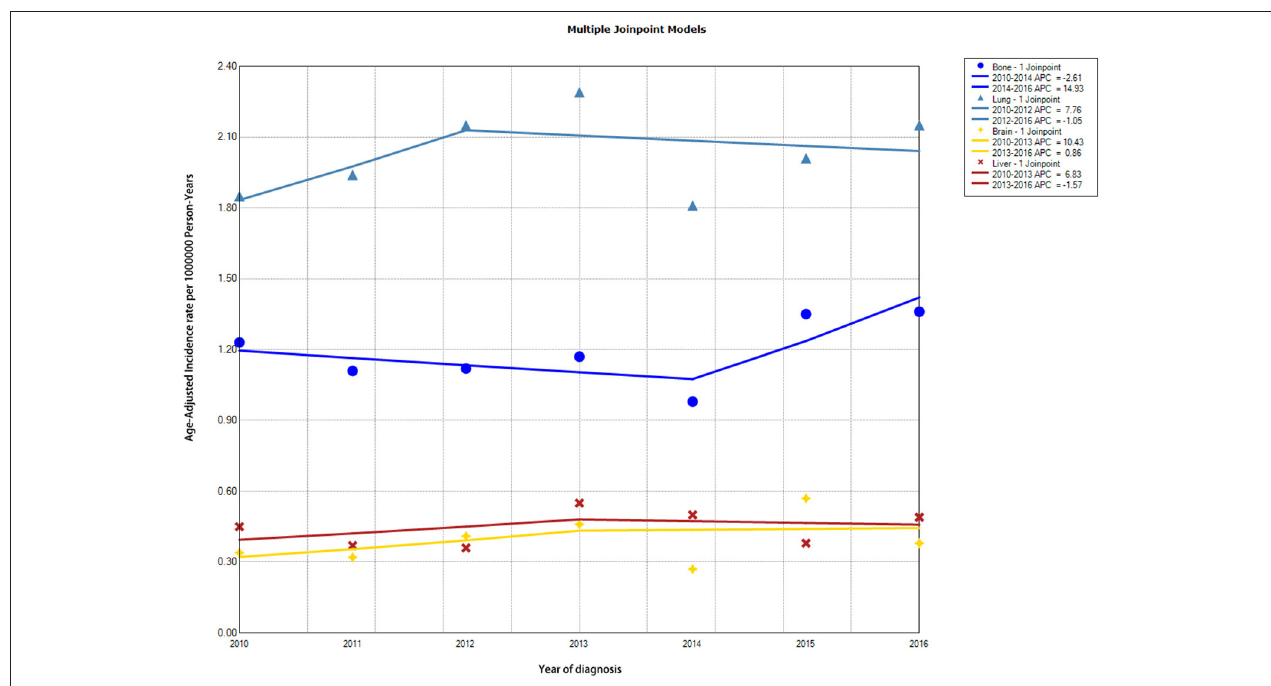
FIGURE 2 | Trends in annual incidence rates of DTC with different distant metastasis to specific sites. DTC, differentiated thyroid cancer.